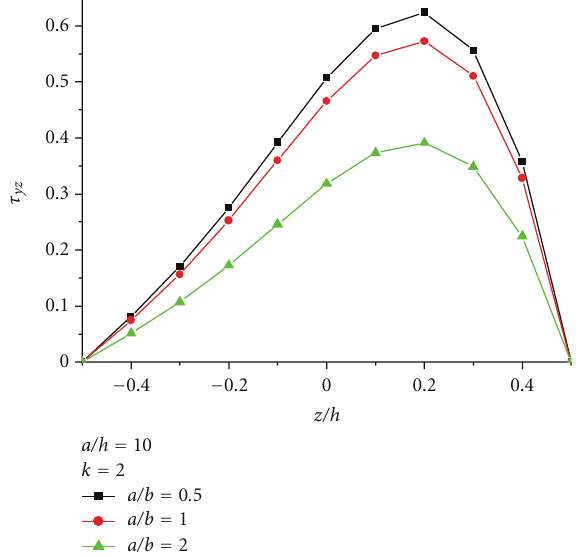
Figure 8: Variation of transversal shear stress ( τ yz ) through-the thickness of an FGM plate for di ff erent values of the aspect ratio.